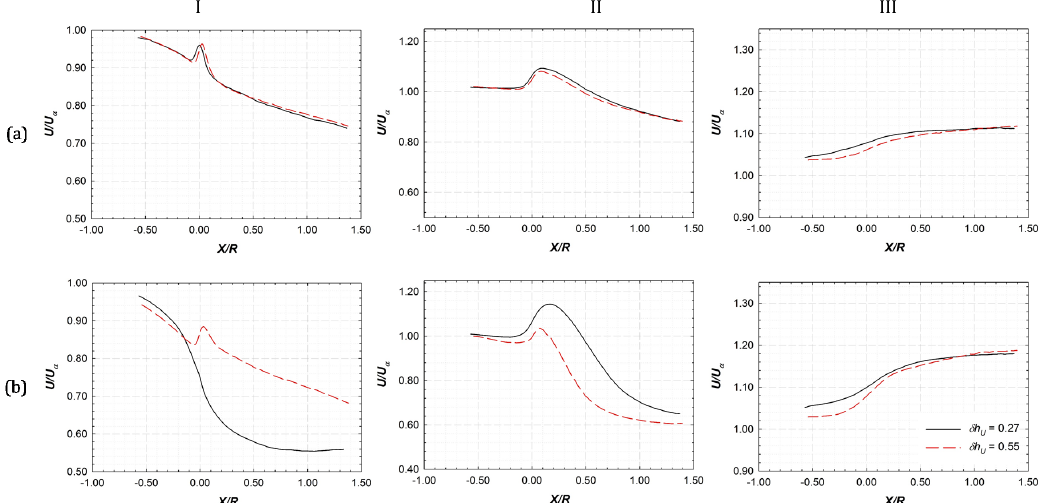
Figure 11. Variation of normalized stream-wise velocities in the lower bypass region for rotational velocity of 180 (row a ) and 270 RPM (row b ) and tip clearance ratios of 0.55 and 0.27 on horizontal lines at various depths: Y / R = − 0.5 (column I ), Y / R = − 1 (column II ), and Y / R = − 1.3 (column III